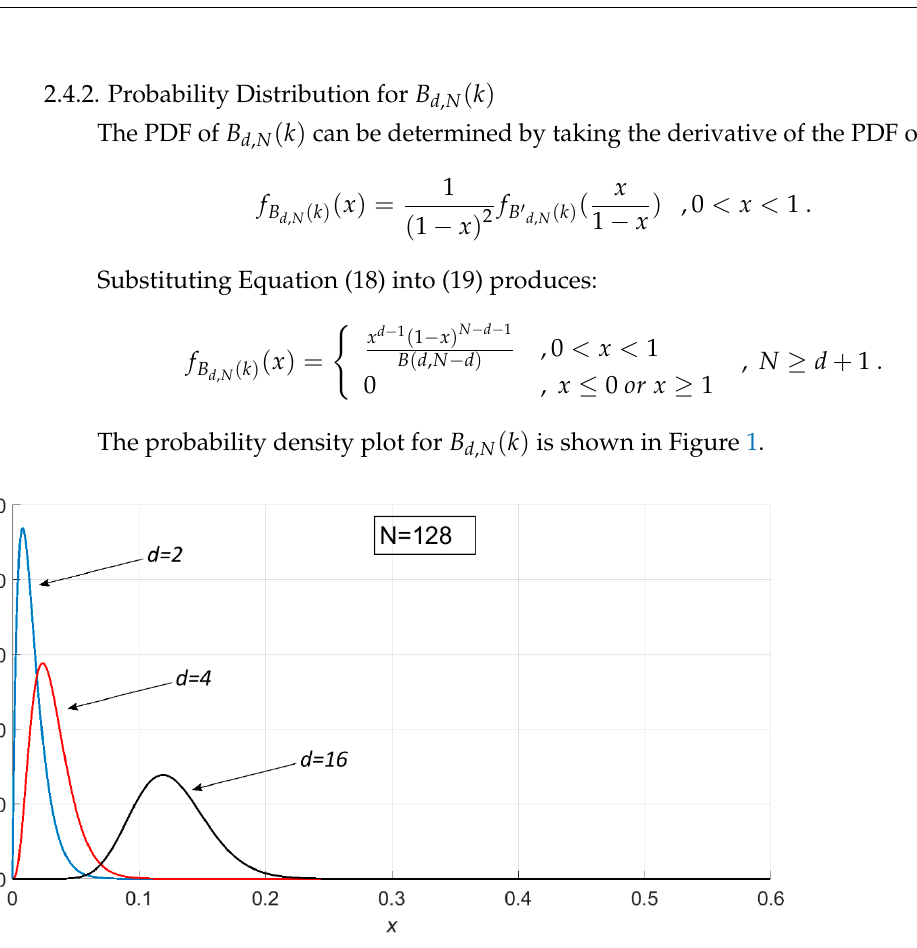
( ) Figure 1. Probability density plot for B k , where N = 128 and d = 2, 4, and 16. Figure 1. Probability density plot for B ( k ) , where N = 128 and d = 2, 4, and 16. , d N d , N According to the PDF of the beta distribution, B d , N ( k ) follows a beta distribution with parameters d , N − d ,